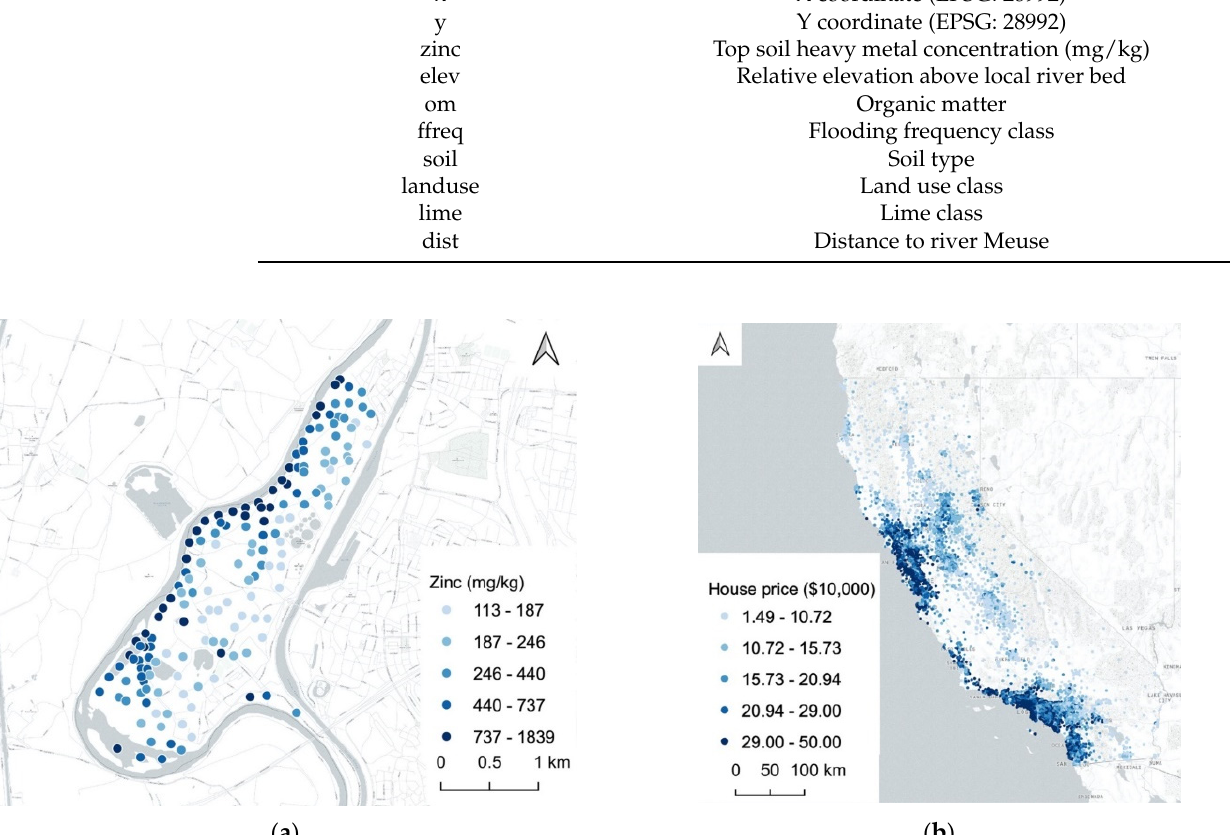
Figure 2. Distribution of samples using quantile breaks; ( a ) Meuse River dataset and ( b ) California housing